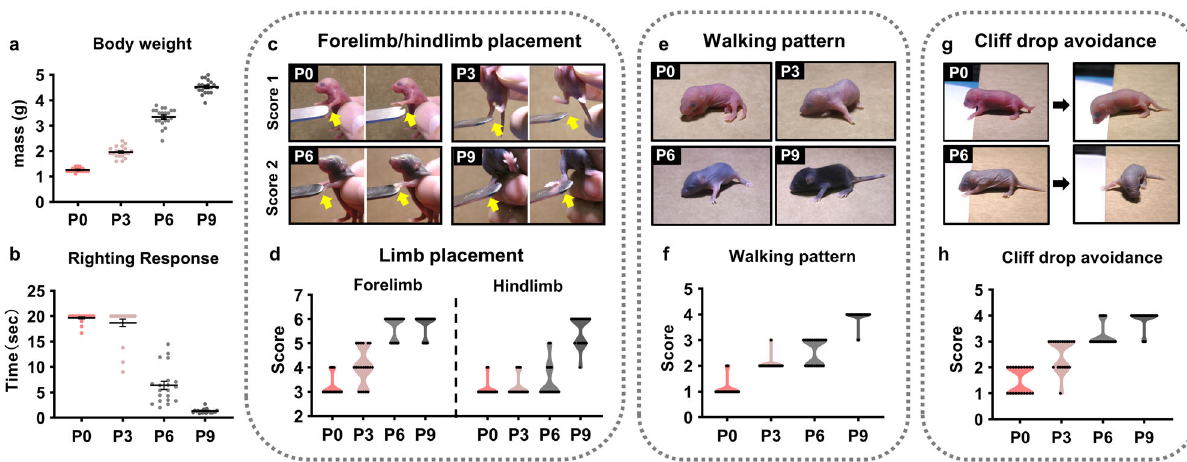
Fig. 1 The measurement of motor development in neonatal mice. a Weight (in grams) of postnatal mouse pups. b The average time taken to complete the righting response. When a pup failed to reach the adult pattern within 20 s, its time was recorded as 20 s. c The test for the limb placing response. d The scores for forelimb and hindlimb placing responses after birth. e The walking pattern in the open- fi eld experiment during postnatal development. f The scores for the characteristics of the walking pattern at different time points. g The test for cliff drop avoidance. h The scores for the motor performance test when the pups faced the cliff at different time points. n = 20 independent animals for each behavioral